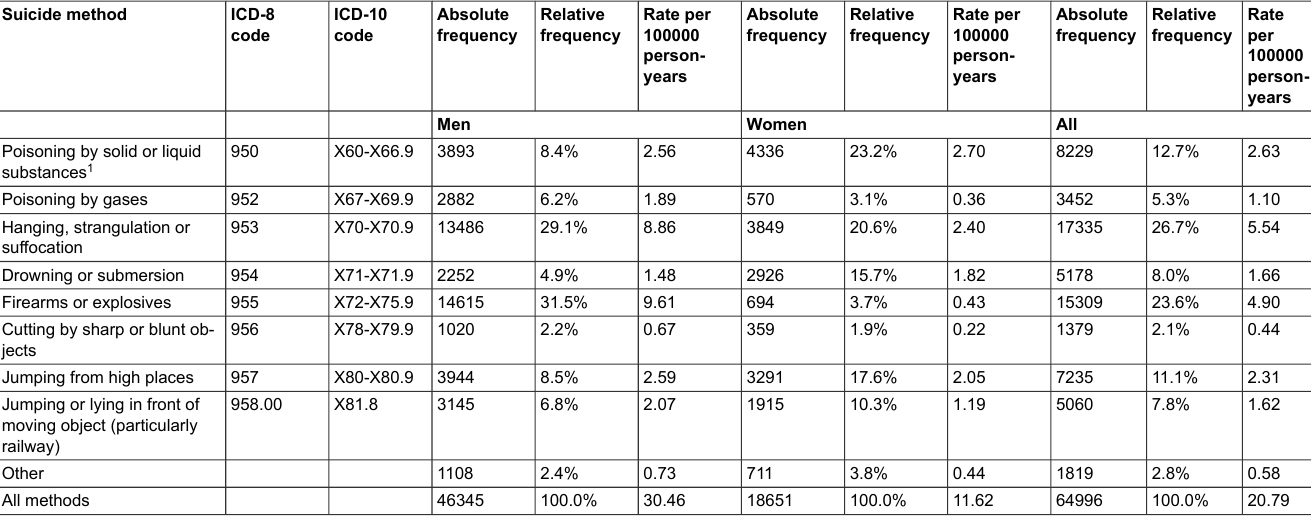
Table 2: Methods of suicides used in Switzerland (1969–2018). Suicide